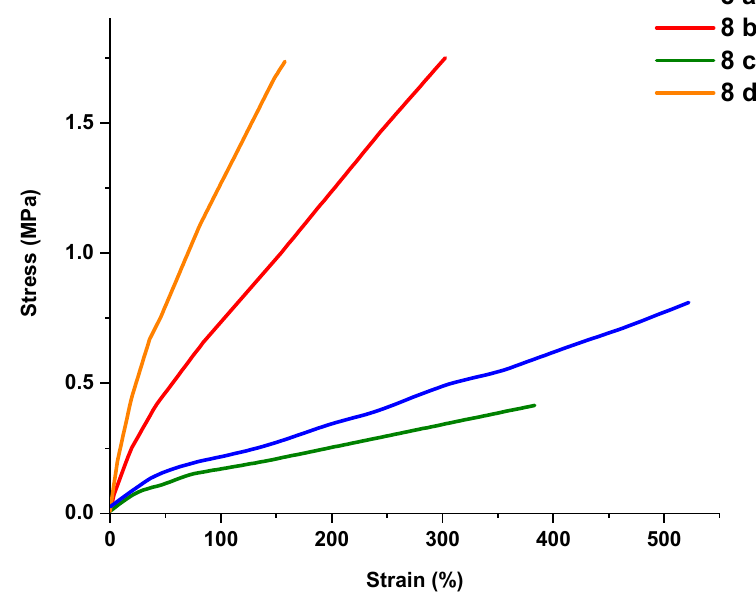
Figure 8. Stress–strain curves of cross-linked polymers 8 a – d . Table 2. Mechanical properties of cross-linked polymers 8 a – d . Polymer